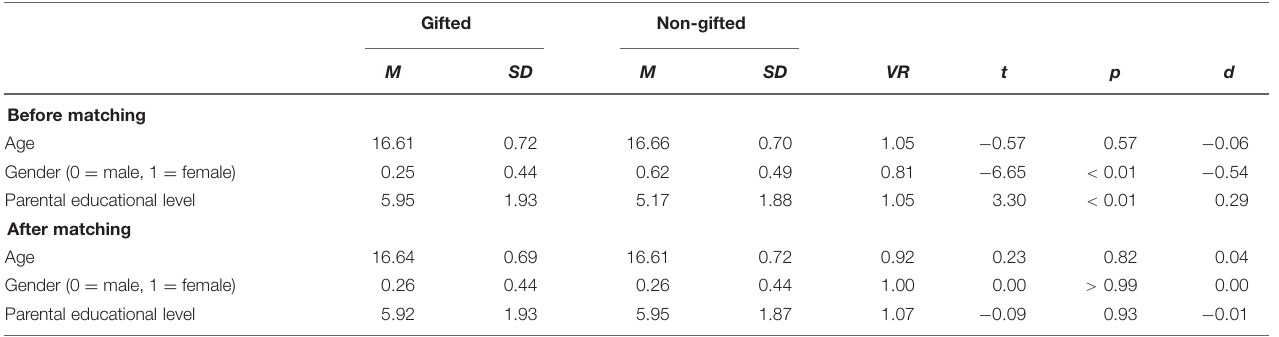
TABLE 1 | Means (M), standard deviations (SD), and variance ratios (VR) of gifted and non-gifted students on the covariates before and after 1:1 nearest neighbor caliper ( c = 0.1) matching without replacement.